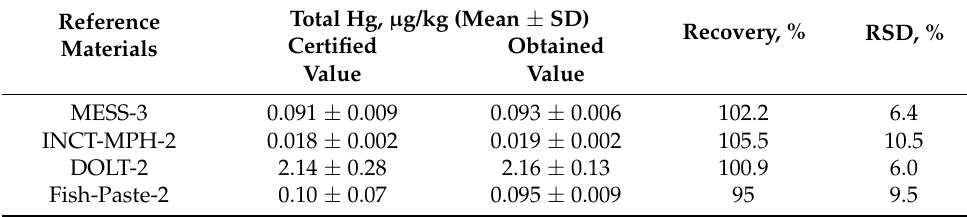
Table 1. Accuracy of the methods applied in the